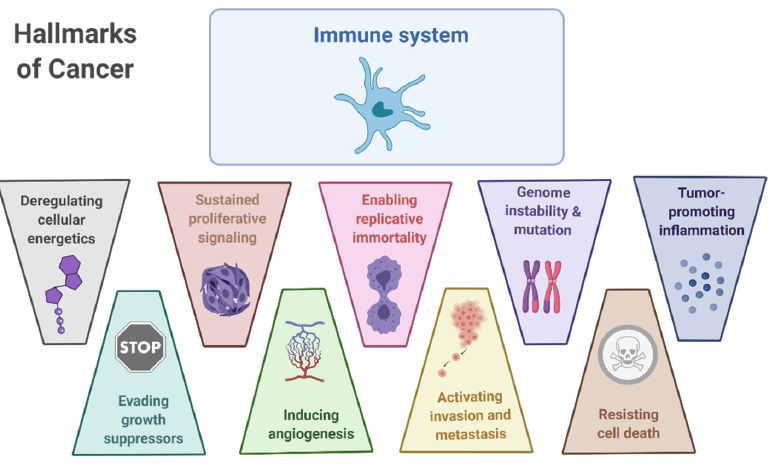
Figure 1. The immune system within the cancer hallmarks plays a pivotal role in understanding of the TME.